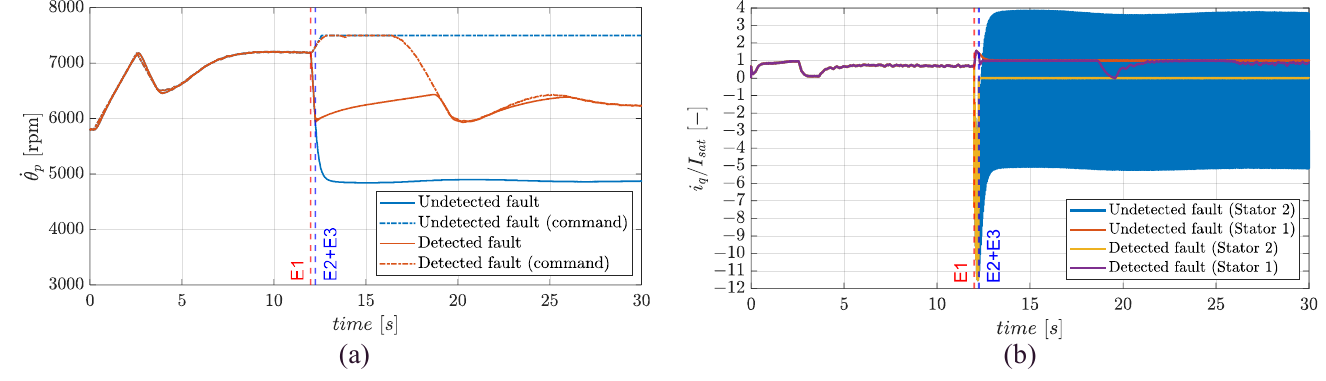
Figure 10. FEPS response in climb with phase-to-ground fault on stator 2 (E1, E2 and E3 defined in Section 3.1): propeller speed ( a ), quadrature current ( b ), with I sat = 46 Arms .